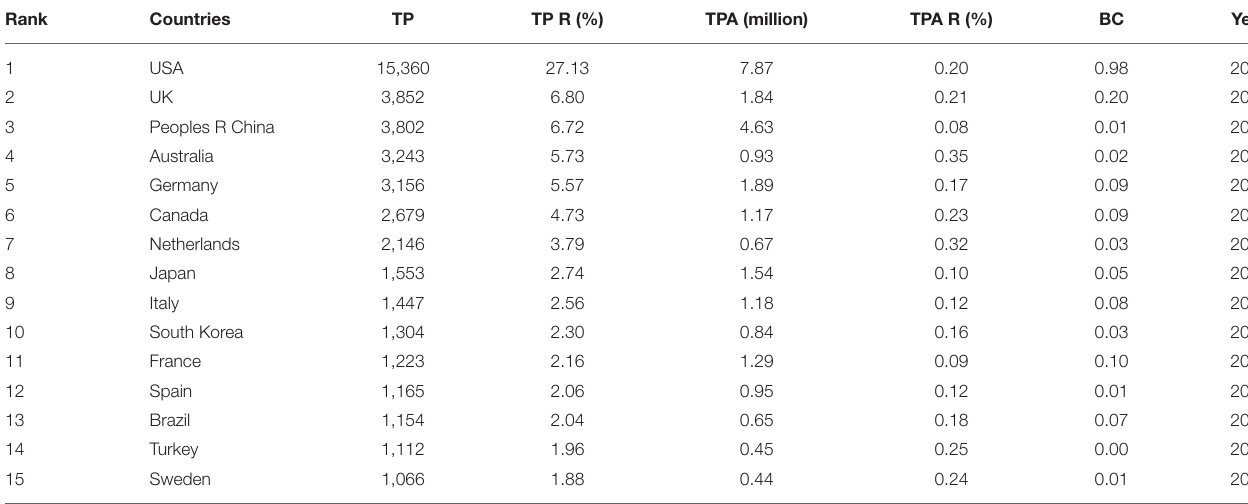
TABLE 1 | The top 15 productive